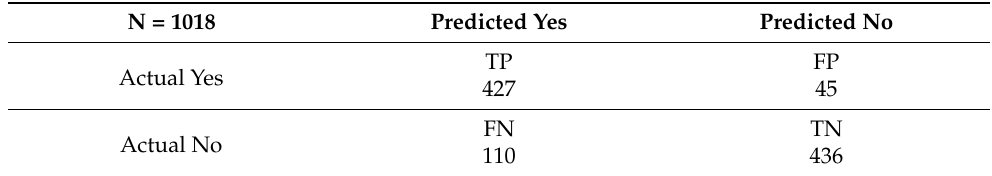
Table 2. Confusion matrix for the CNN.